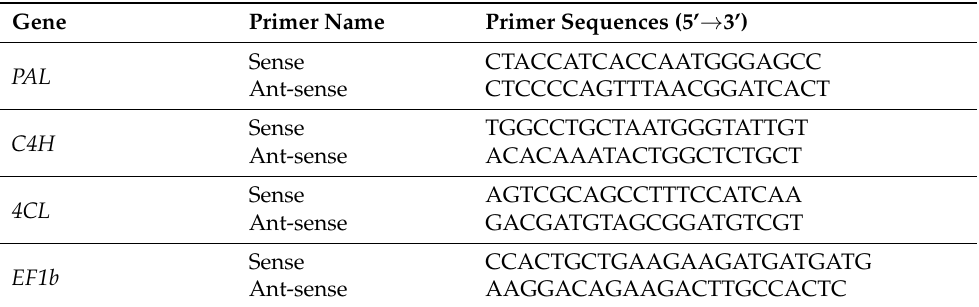
Table 1. Primer sequences for genes related to phenolics synthesis in soybean.